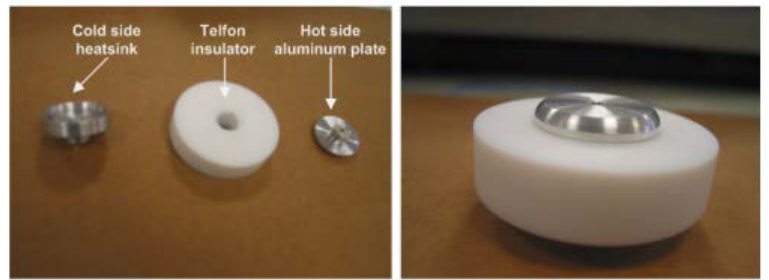
Figure 4. Thermal energy harvesting hardware